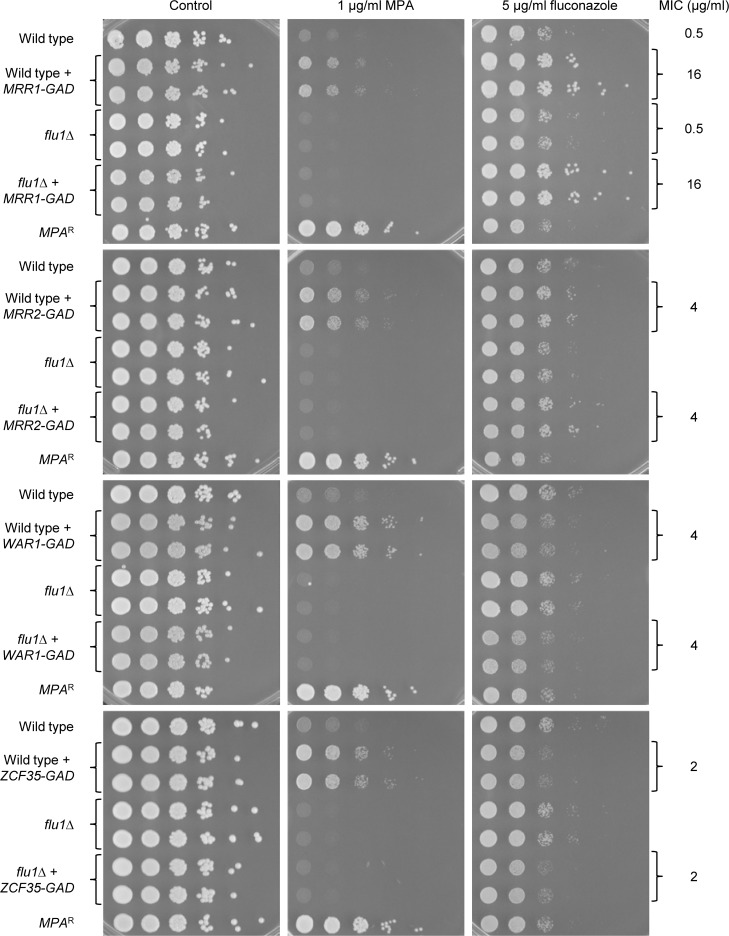
MPA resistance conferred by hyperactive Mrr1, Mrr2, War1, and Zcf35 depends on FLU1.Serial dilutions of the wild type, flu1∆ mutants, and transformants expressing the indicated hyperactive transcription factors were spotted onto SD-CSM agar plates without or with 1 μg/ml MPA or 5 μg/ml fluconazole and grown for 2 days at 30°C. The MICs of fluconazole, as determined in a broth microdilution assay, are given on the right. The following strains were used in these experiments: SC5314 (Wild type), SCFLU1M4A and -B (flu1∆), SCMRR1GAD1A and -B (Wild type + MRR1-GAD), SCΔflu1MRR1GAD1A and -B (flu1∆ + MRR1-GAD), SCZCF34GAD1A and -B (Wild type + MRR2-GAD), SCΔflu1MRR2GAD1A and -B (flu1∆ + MRR2-GAD), SCWAR1GAD1A and -B (Wild type + WAR1-GAD), SCΔflu1WAR1GAD1A and -B (flu1∆ + WAR1-GAD), SCZCF35GAD1A and -B (Wild type + ZCF35-GAD), SCΔflu1ZCF35GAD1A and -B (flu1∆ + ZCF35-GAD). Strain S2UI1, which carries a mutated IMH3 allele that confers MPA resistance (MPAR), was included as an additional control.